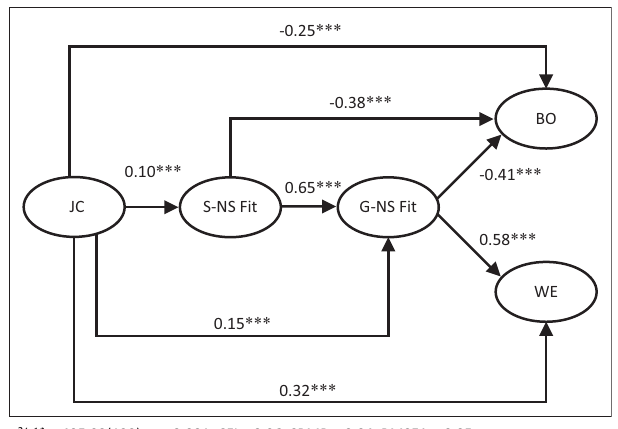
FIGURE 2: Alternative model 5: Completely standardised path